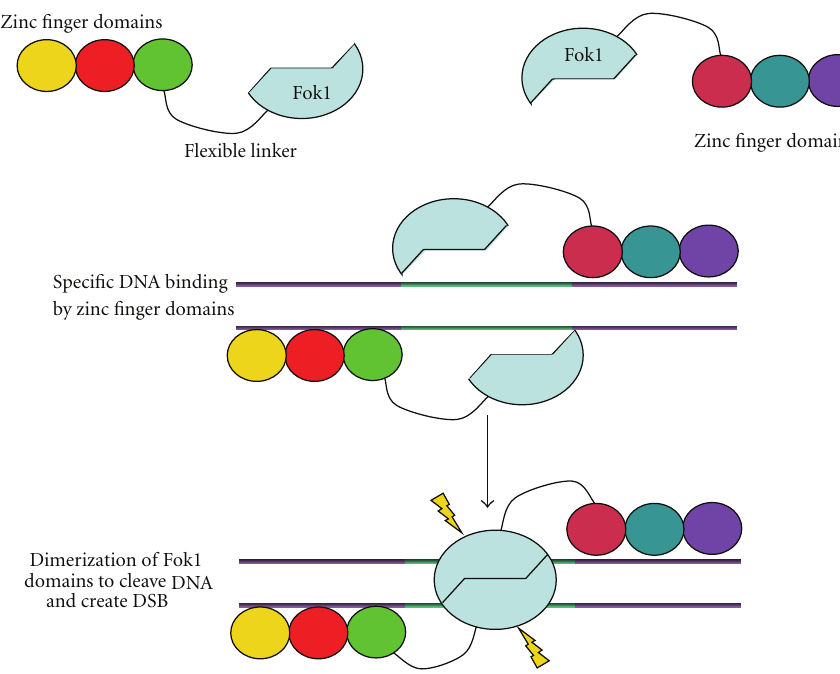
Figure 6: Basic structure and design of a zinc finger nuclease (ZFN). ZFNs are created by joining a DNA-binding region to the catalytic domain of the nonspecific Fok1 endonuclease. Zinc fingers are a protein motif capable of DNA binding, whose sequence specificity can be predetermined. Each zinc finger, illustrated by an individual circle, recognizes 3-4 nucleotides, and, by assembling three or four suitable zinc finger motifs, a sequence-specific DNA-binding domain can be created. Fok1 nuclease activity requires dimerization, and so the customized ZFNs function in pairs. As shown, the zinc finger-binding domain brings two Fok1 units together in the right orientation over the target sequence; this induces Fok1 dimerization and target sequence